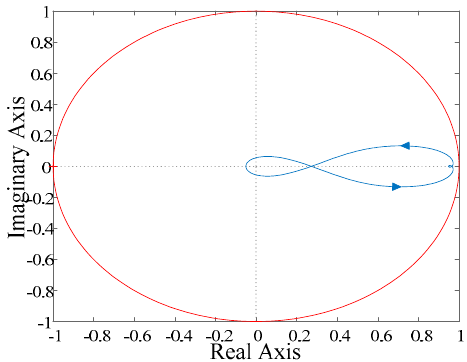
Figure 4. Nyquist diagram of H(z) for shunt APF system.